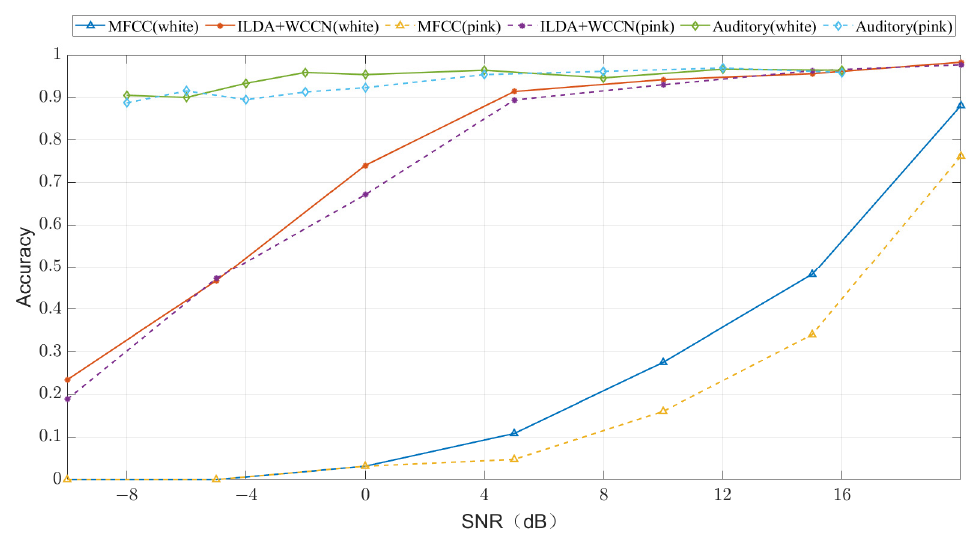
Figure 7. Comparison of auditory analysis and acoustic measurements.